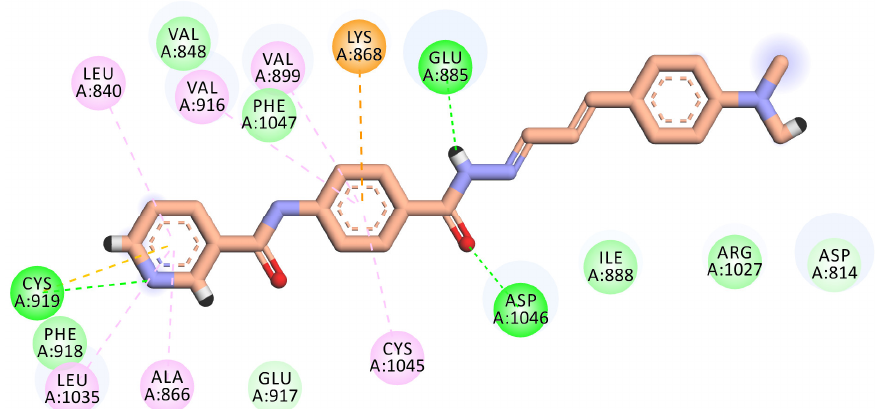
Figure 8. 2D binding mode of compound 8 in the VEGFR-2 active site. H-bonds (dashed green) were formed with Cys919, Glu885, and Asp1046. Hydrophobic interactions (dashed organ) were formed with Leu840, Leu1035, Cys919, Ala866, Val899, Val916, Lys868, and Cys1045.